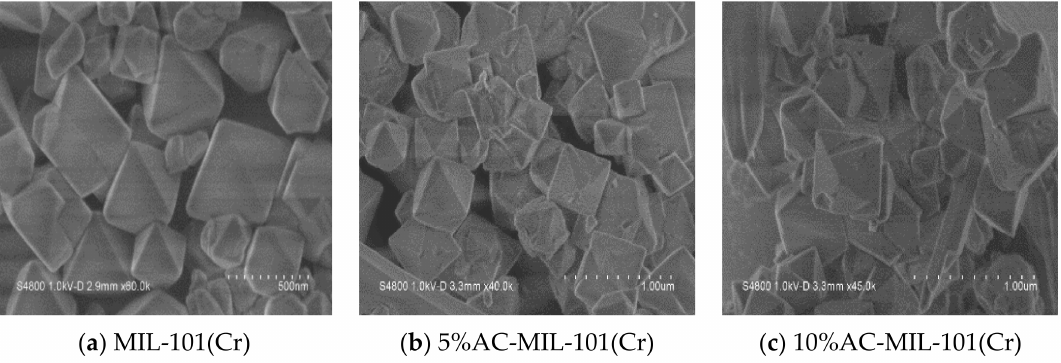
Figure 3. SEM images of ( a ) MIL-101(Cr); ( b ) 5% AC-MIL-101(Cr) and ( c ) 10% AC-MIL-101(Cr)